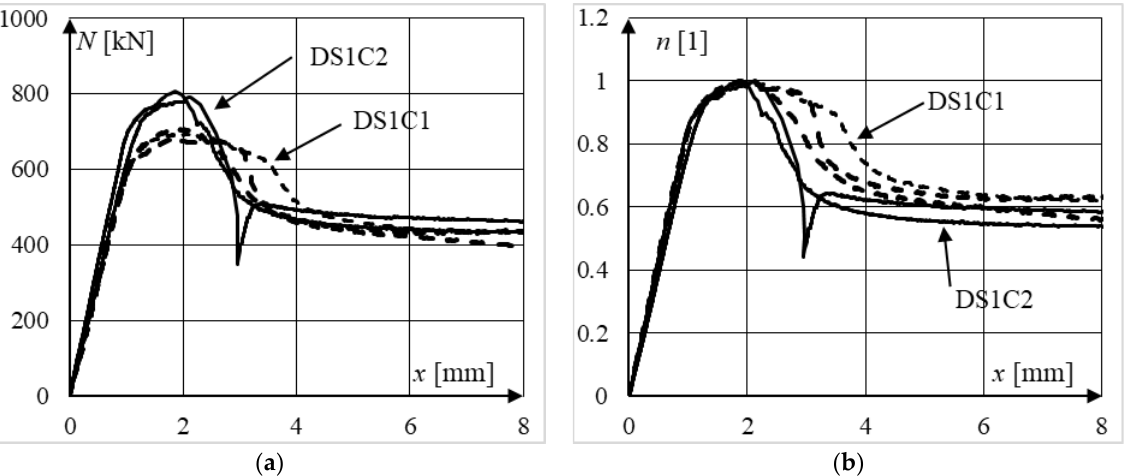
Figure 15. Comparison of ( a ) non-normalized and ( b ) normalized equilibrium paths of moderately slender elements from series DS1C1 and DS1C2 (different concrete strength).